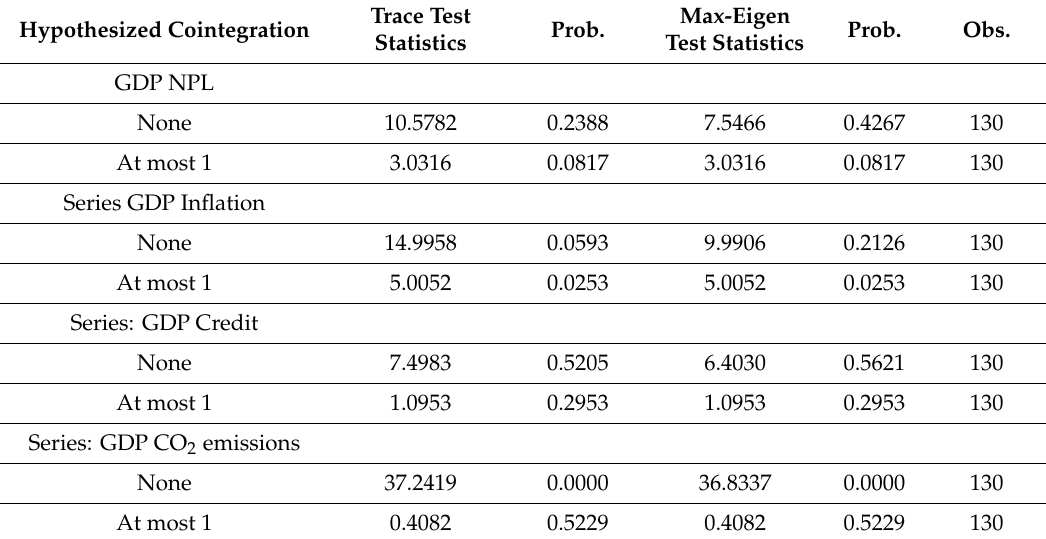
Table 10. Individual cross-section